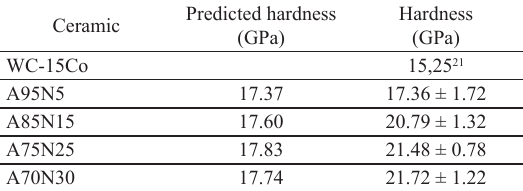
Table 2. Hardness of NbC-Al Ceramic